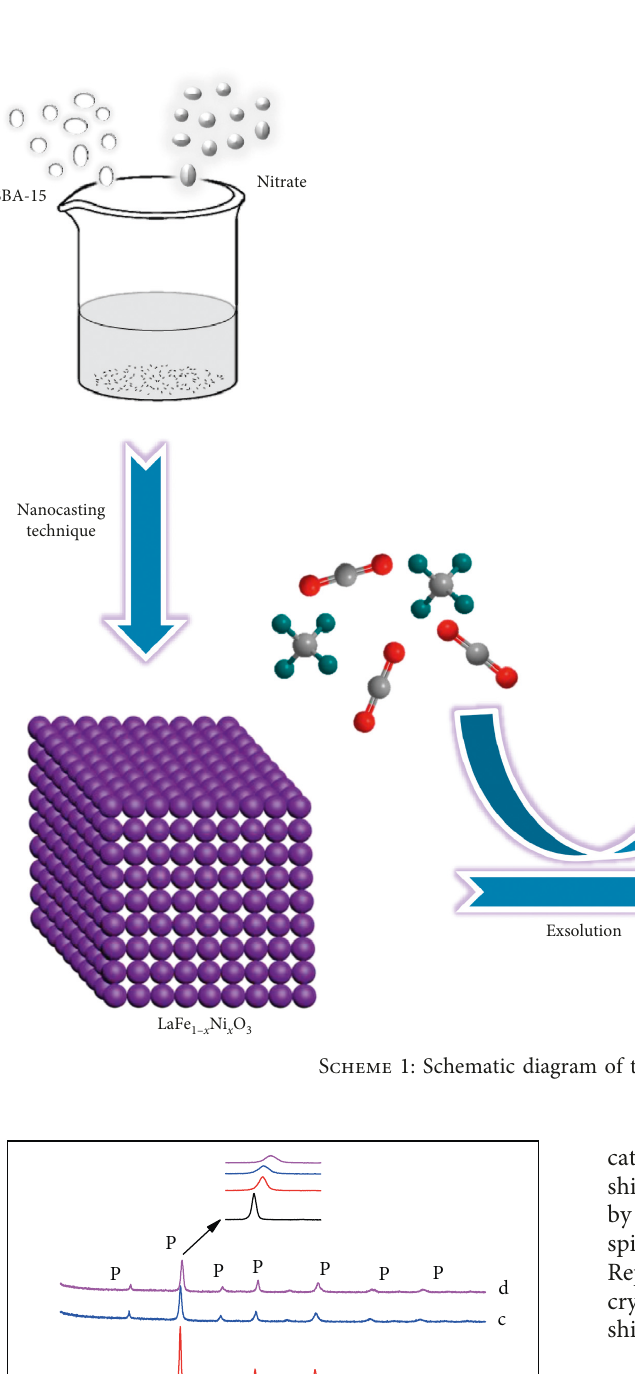
3 , (b) LaFe 0.7 Ni 0.3 O 3 ,